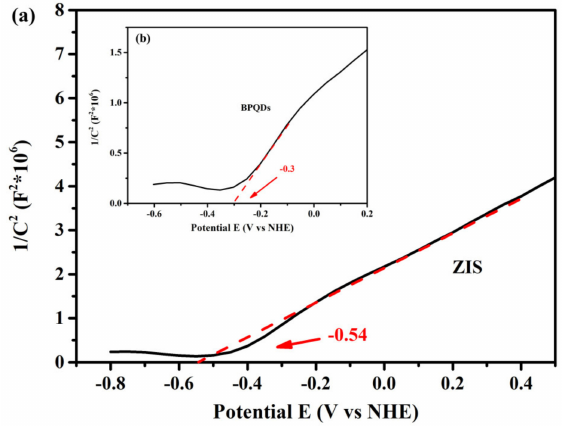
Figure 10. The Mott–Schottky plots of pure ZnIn 2 S 4 ( a ) and BPQDs ( b